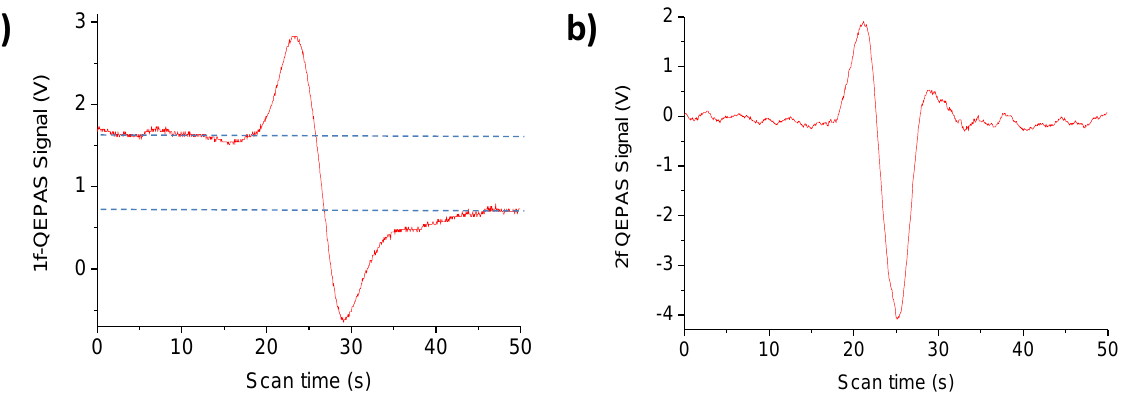
line centered at 2,311.515 cm −1 . Blue lines highlight the 2